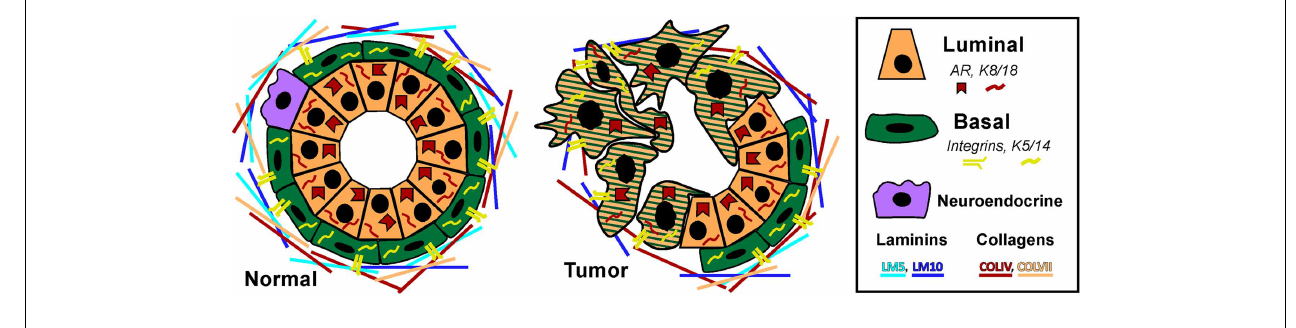
express integrins, but do express AR and keratins K8 and K18. A prominent characteristic of prostate tumors is the loss of basal cells and a loss of LM5 and COLIV. Correspondingly, the integrins that interact with these matrices, α 3 β 1 and α 6 β 4 are lost via loss of the α 3 and β 4 subunits, leaving integrin α 6 β 1 which prefers the LM10 matrix. Similarly, tumor cells often co-express basal and luminal keratins, such as K5 and